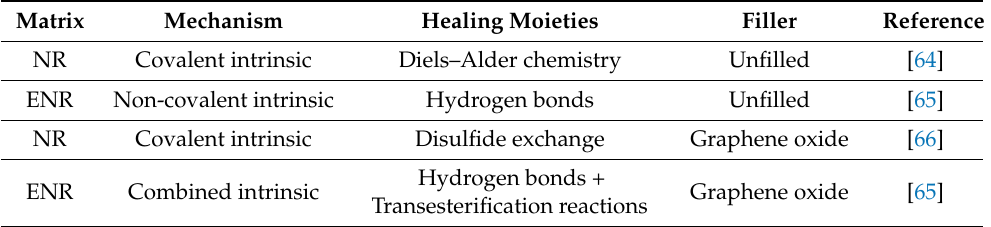
Table 1. Self-healing natural rubber research conducted in Spain